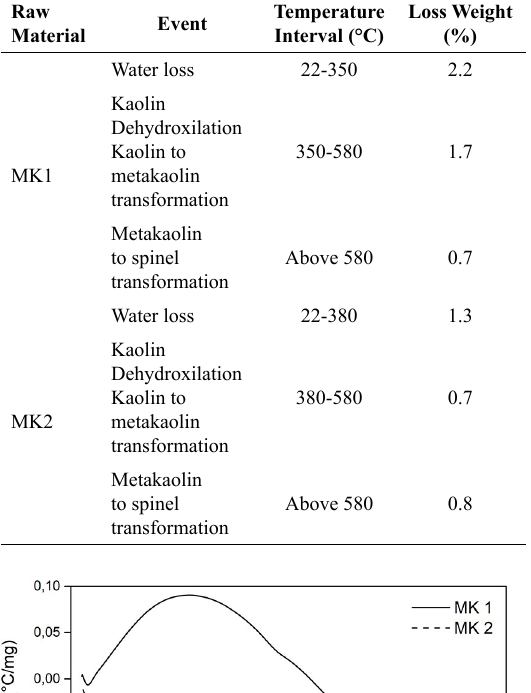
Figure 3. TGA curves of MK1 and MK2. Table 4. Mass loss intervals for raw materials (MK1 and MK2).